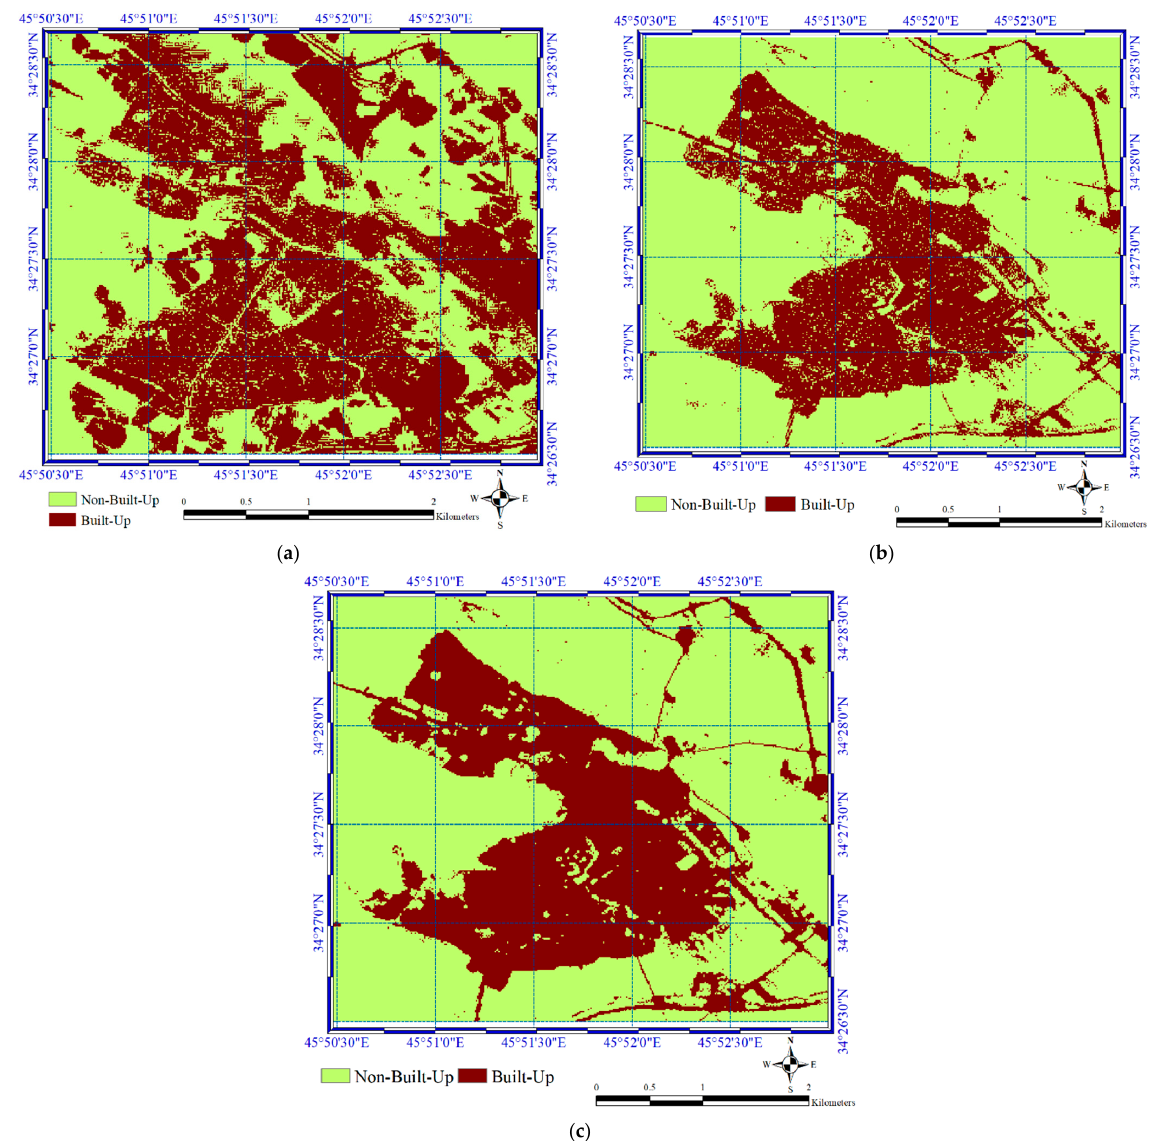
Figure 6. The result of built-up detection on both datasets. ( a ) The ND-Based method in Sarpol-Zahab, ( b ) Proposed method in Sarpol-Zahab, and ( c ) Ground Truth of Sarpol-Zahab.